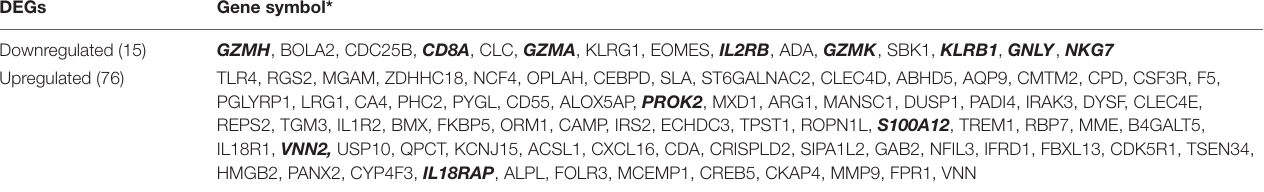
TABLE 1 | Ninety-one DEGs were identified from GSE60993 and GSE61144 microarrays for STEMI.